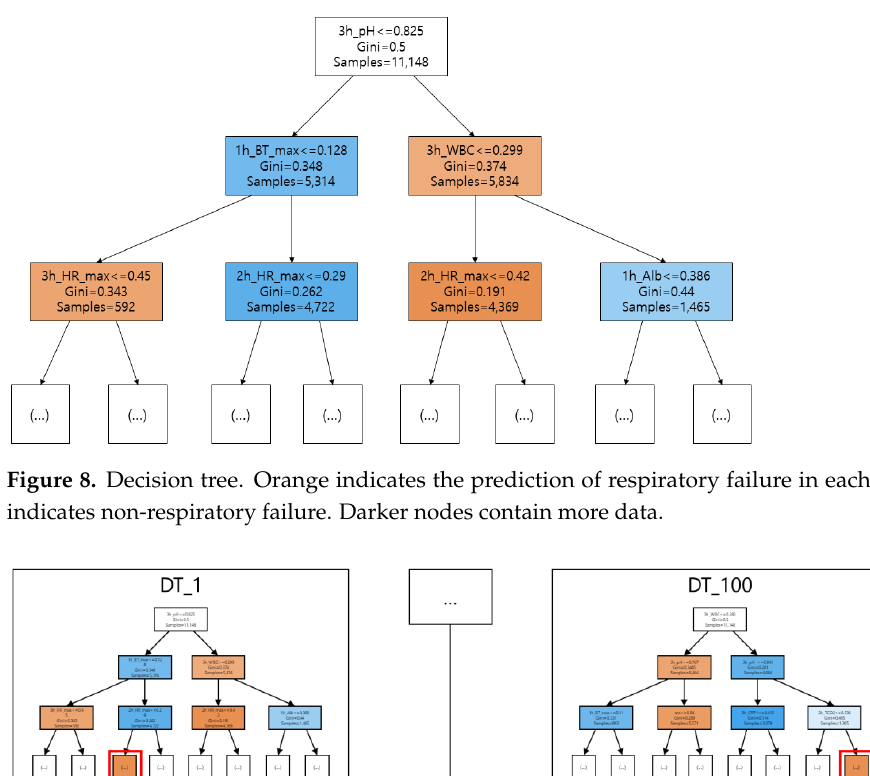
Figure 9. Processing of random forests. The red box in the decision tree indicates the predicted outcome. The random forest classifier is based on decision tree outcomes. Random Forest performs bootstrap aggregation on many decision trees and uses voting to determine the prediction results of many decision trees.